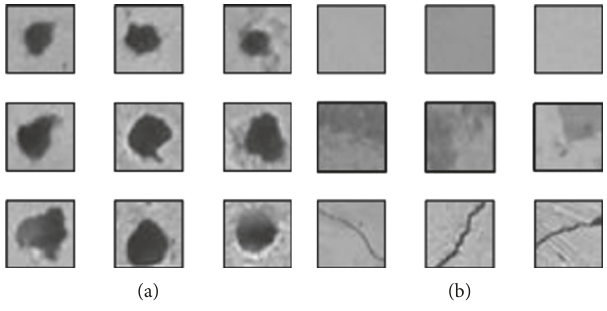
Figure 5: Positive and negative samples.